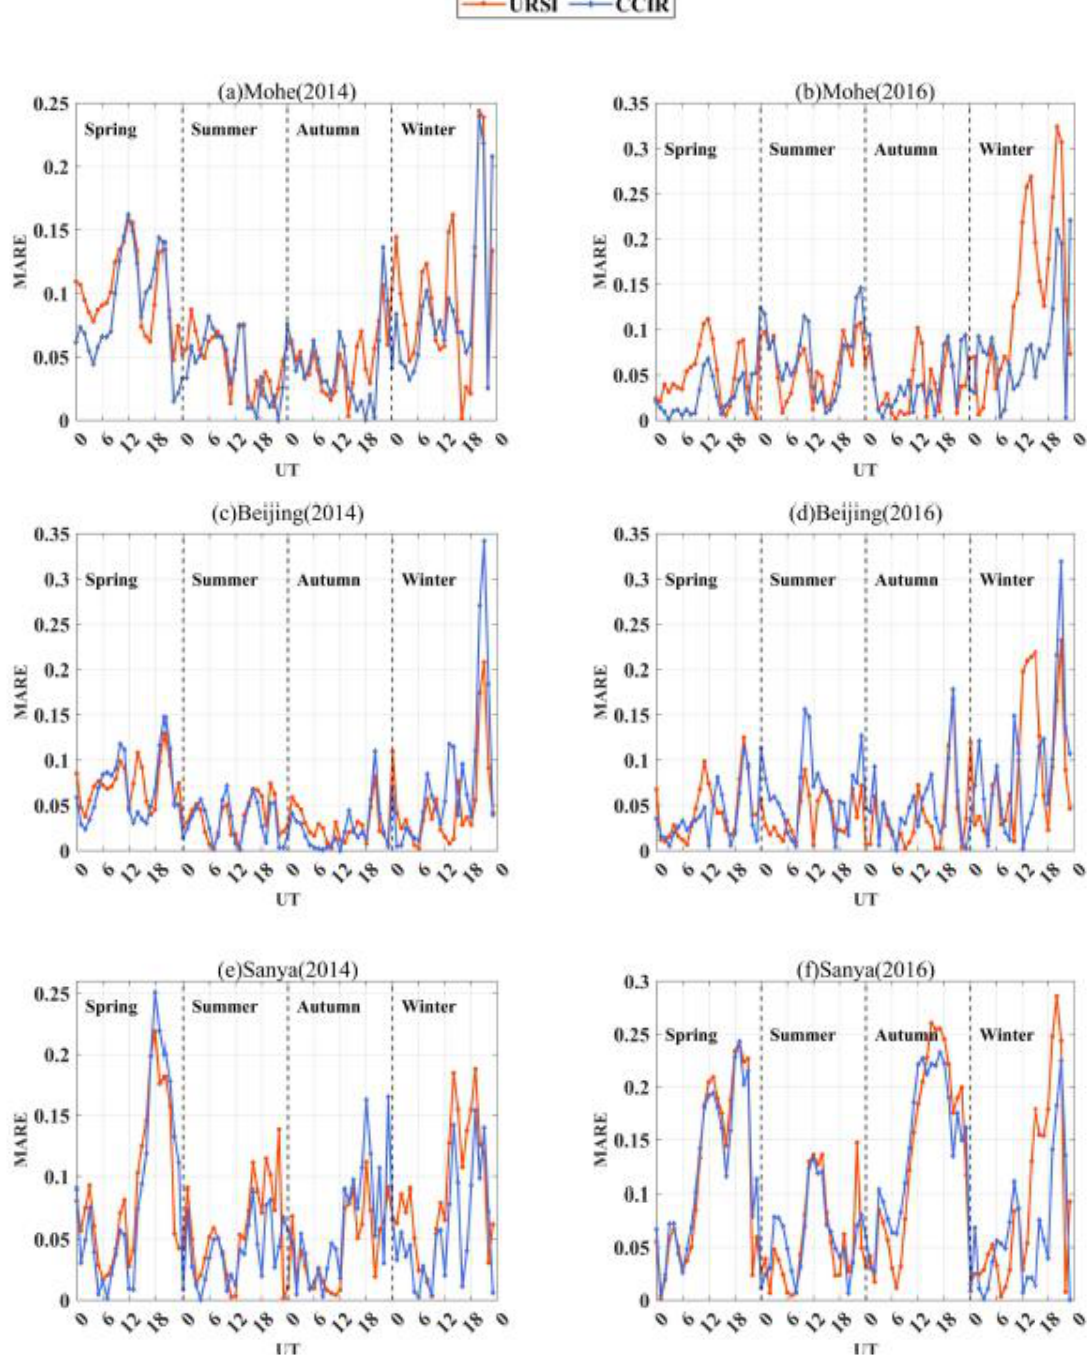
Figure 6. Diurnal MARE variation of IRI-2016 URSI and CCIR predicted foF2 from the ionosonde